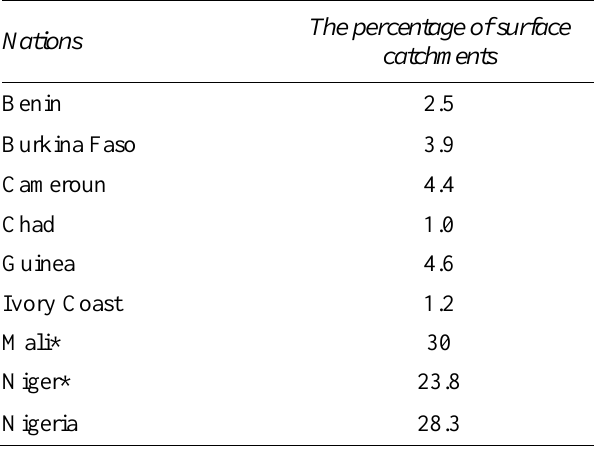
Table 2.1: Water distribution rate - The distribution of surface catchment’s area Nations